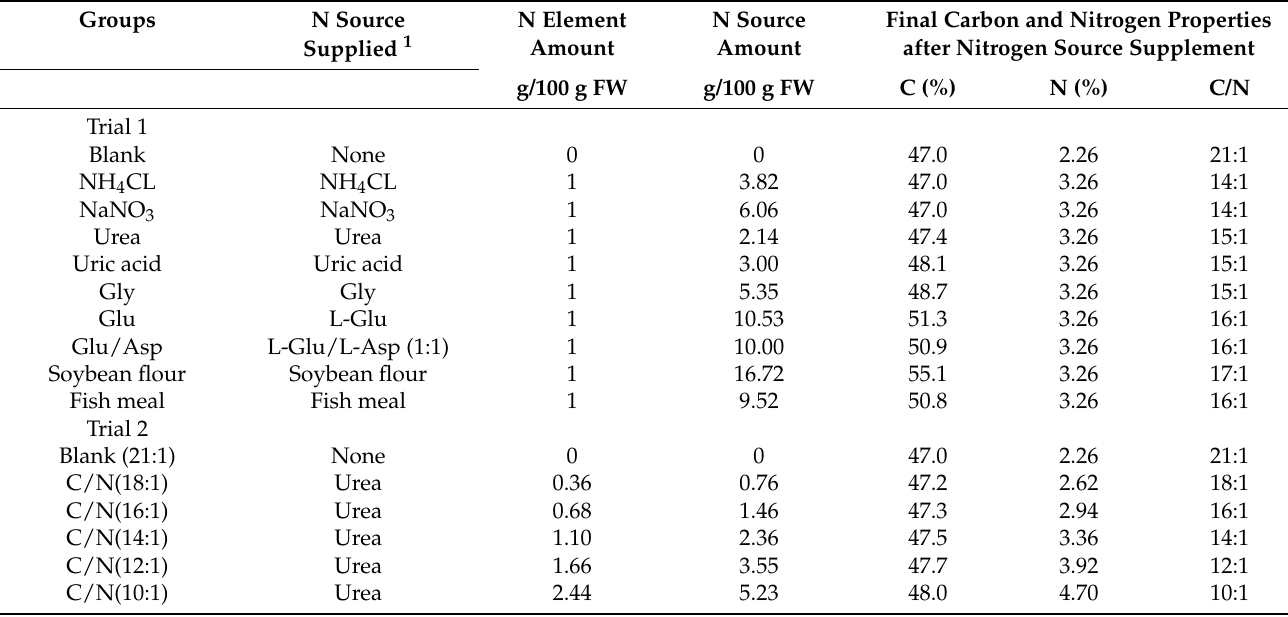
Table 1. Experimental design of nitrogen source supplied in Trials 1 and